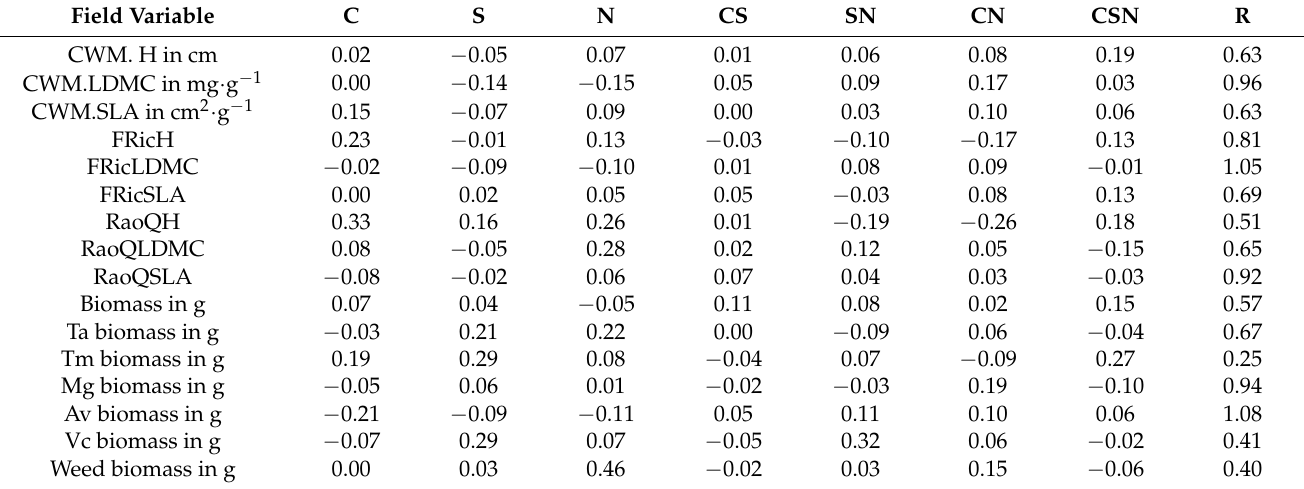
Table 4. Results of variance partition. C corresponds to the variance explained by color analysis alone, S corresponds to the variance explained by segmentation alone, N corresponds to the variance explained by NIRS variables alone, CS corresponds to the joint variance between the colors and segmentation, SN corresponds to the joint variance between NIRS and segmentation, CN corresponds to the joint variance between NIRS and segmentation, and CSN is the variances explained by the three different groups combined. R corresponds to the unexplained variances